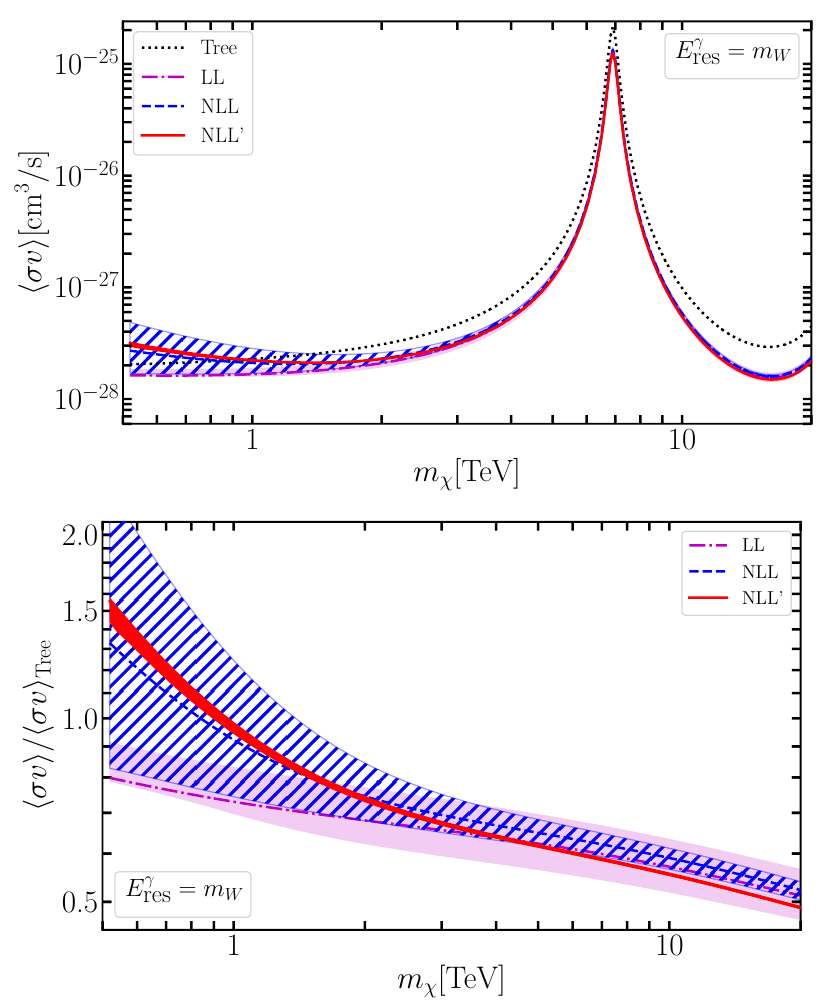
Figure 2 . Integrated photon energy spectrum within E (cid:13) (Sommerfeld only) and LL, NLL, NLL 0 resummed approximations. The energy resolution is set to E (cid:13) = m W and the mass splittings are (cid:14)m = 355 MeV and (cid:14)m N = 20 MeV. The shaded/hatched res bands show the scale variation of the respective approximation. For the NLL 0 result the theoretical uncertainty is given by the thickness of the red